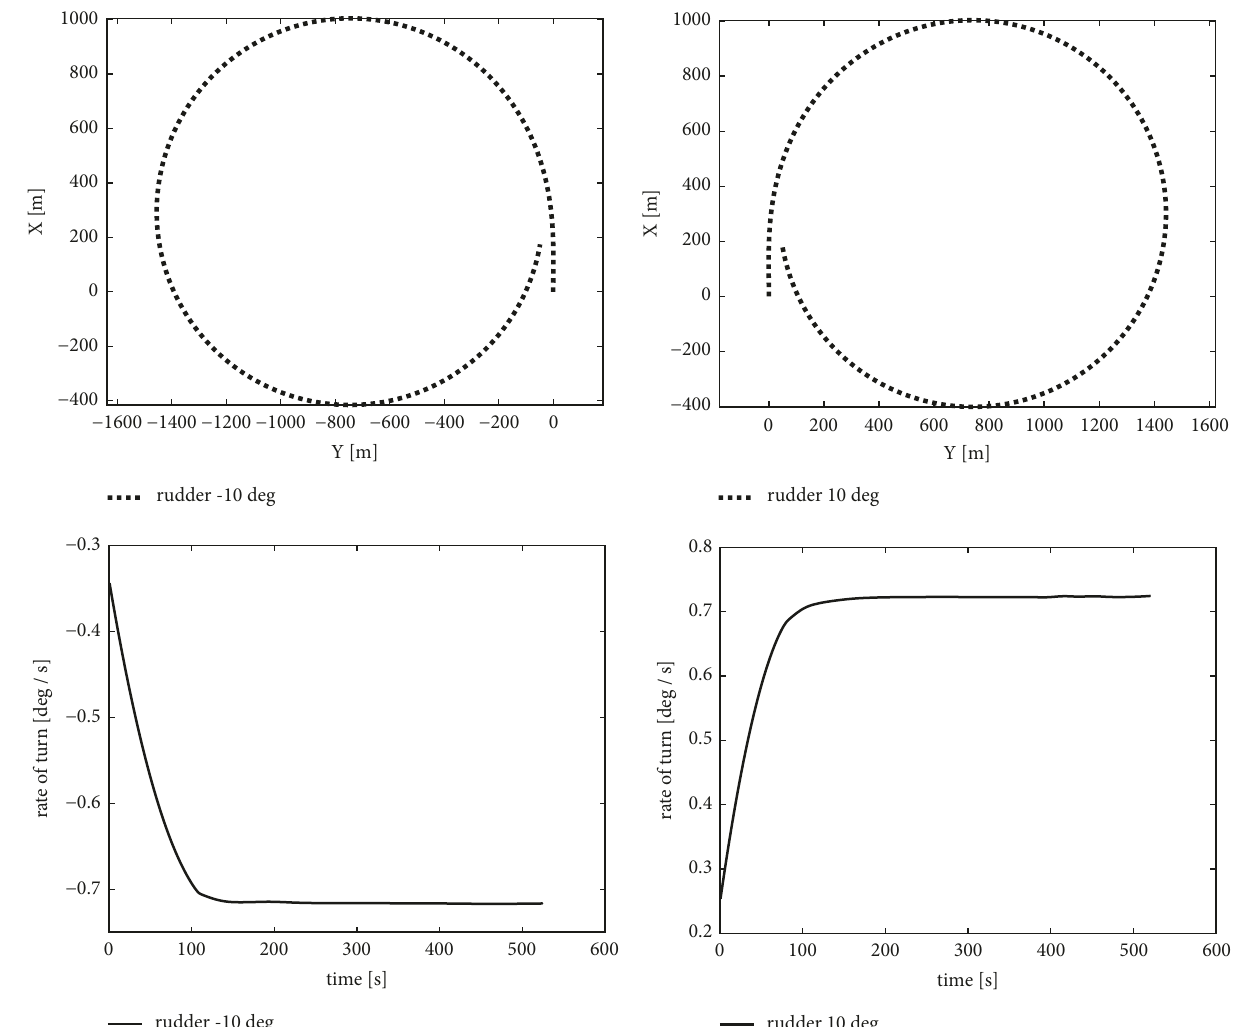
Figure 8: Results of LaiDyn simulations for the considered ro-pax for rudder setting 10